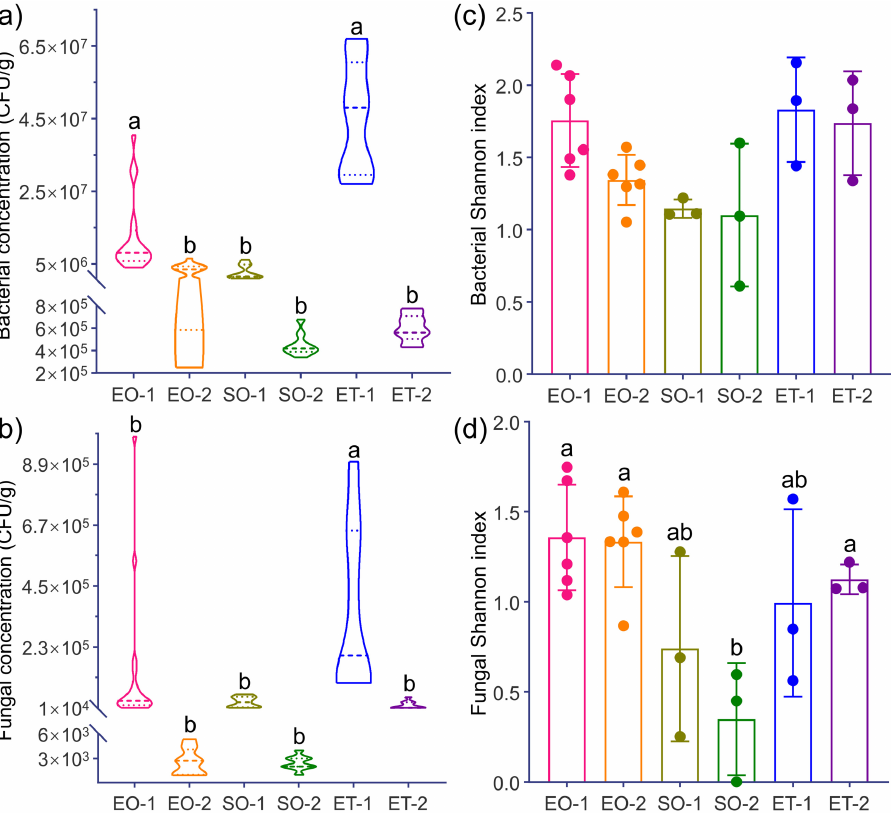
Figure 3. The concentrations and Shannon index values for culturable bacteria and fungi (CFUs g − 1 ) from the different sampling sites. Significant results are indicated with different letters. ( a ) Bacterial concentration; ( b ) Fungal concentration; ( c ) Bacterial Shannon index; ( d ) Fungal Shannon index.